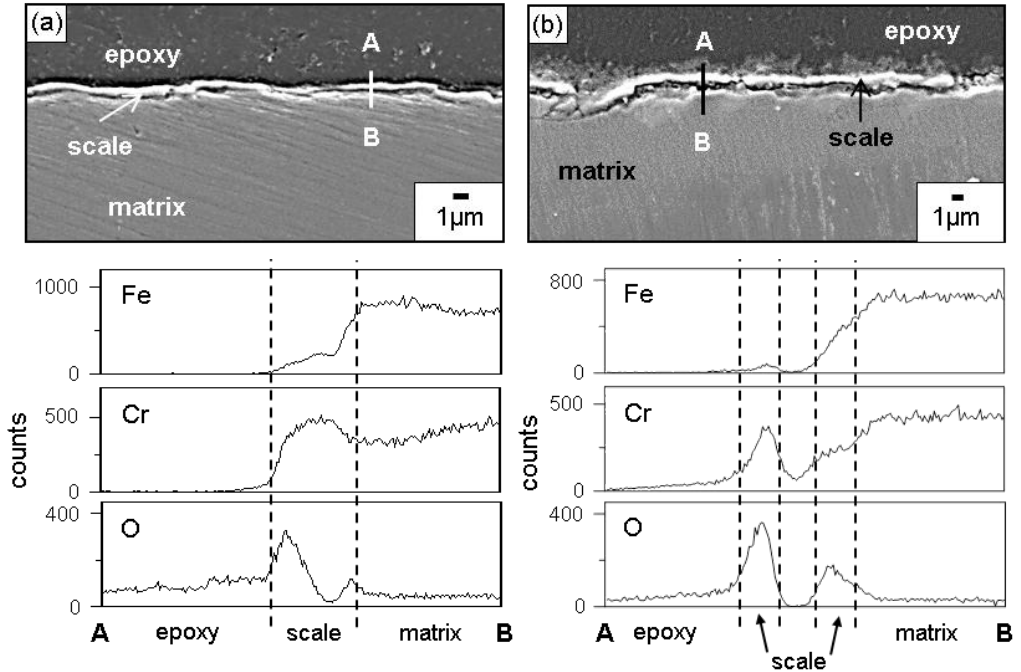
Figure 4. EPMA cross-section and line profiles of Fe-37Cr after corrosion at 700 °C for 70 h in ( a ) N 2 ; and ( b ) N 2 /3.2%H 2 O.